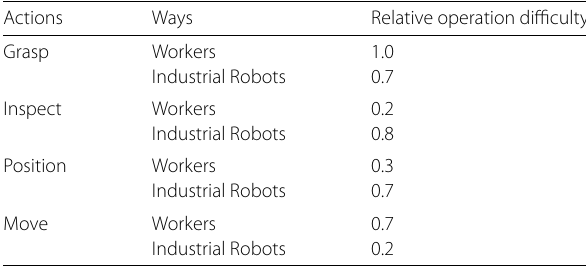
Table 2 Difficulty of different